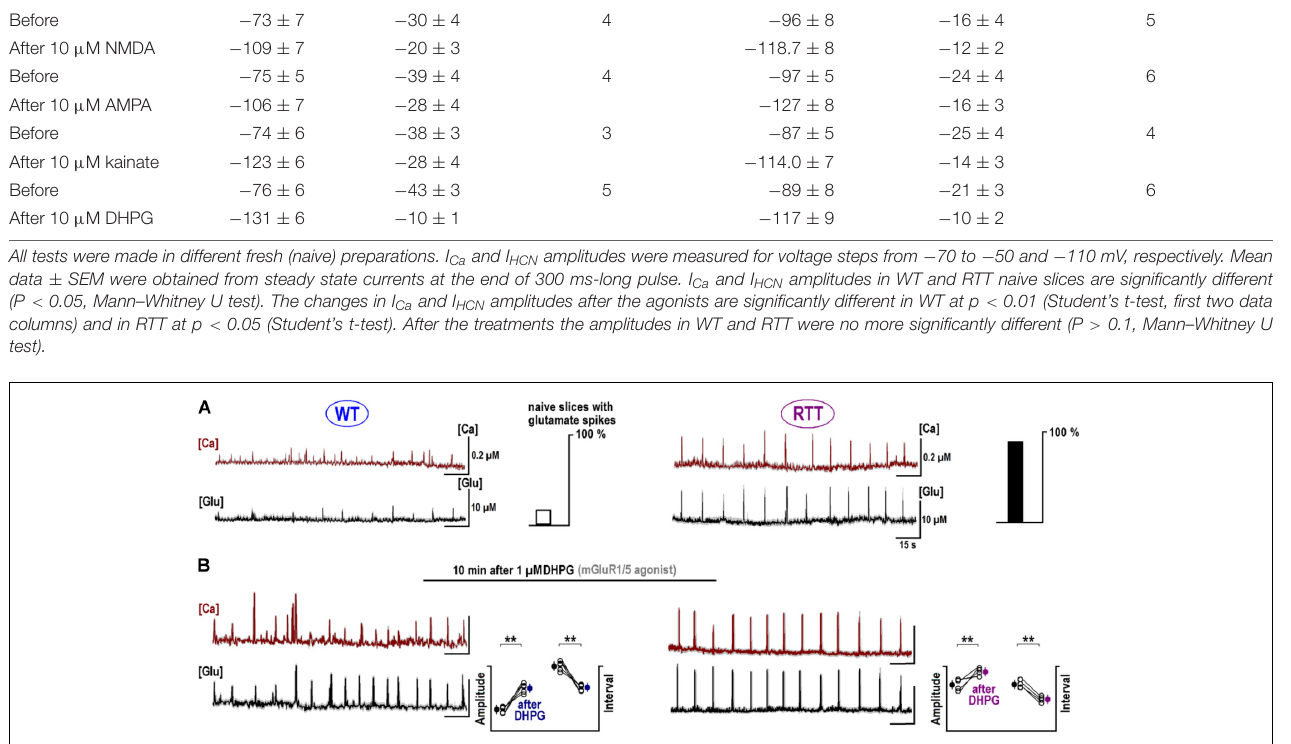
FIGURE 4 | Potentiation of repetitive calcium and glutamate transients after DHPG. The sample traces show the changes in calcium (brown, measured with Fura-2) and ambient glutamate (black, measured with iGluSnFr). Note a close correspondence between both activities. The data are mean responses of 12 neurons in the image field overlaid on gray background showing ± SEM. (A) Spontaneous activity in naive slices from the WT and RTT animals. Only 4 out of 25 naive WT slices demonstrated spontaneous glutamate and calcium activities and almost all naïve RTT preparations were “rhythmic” (21 out of 26, the insets give group